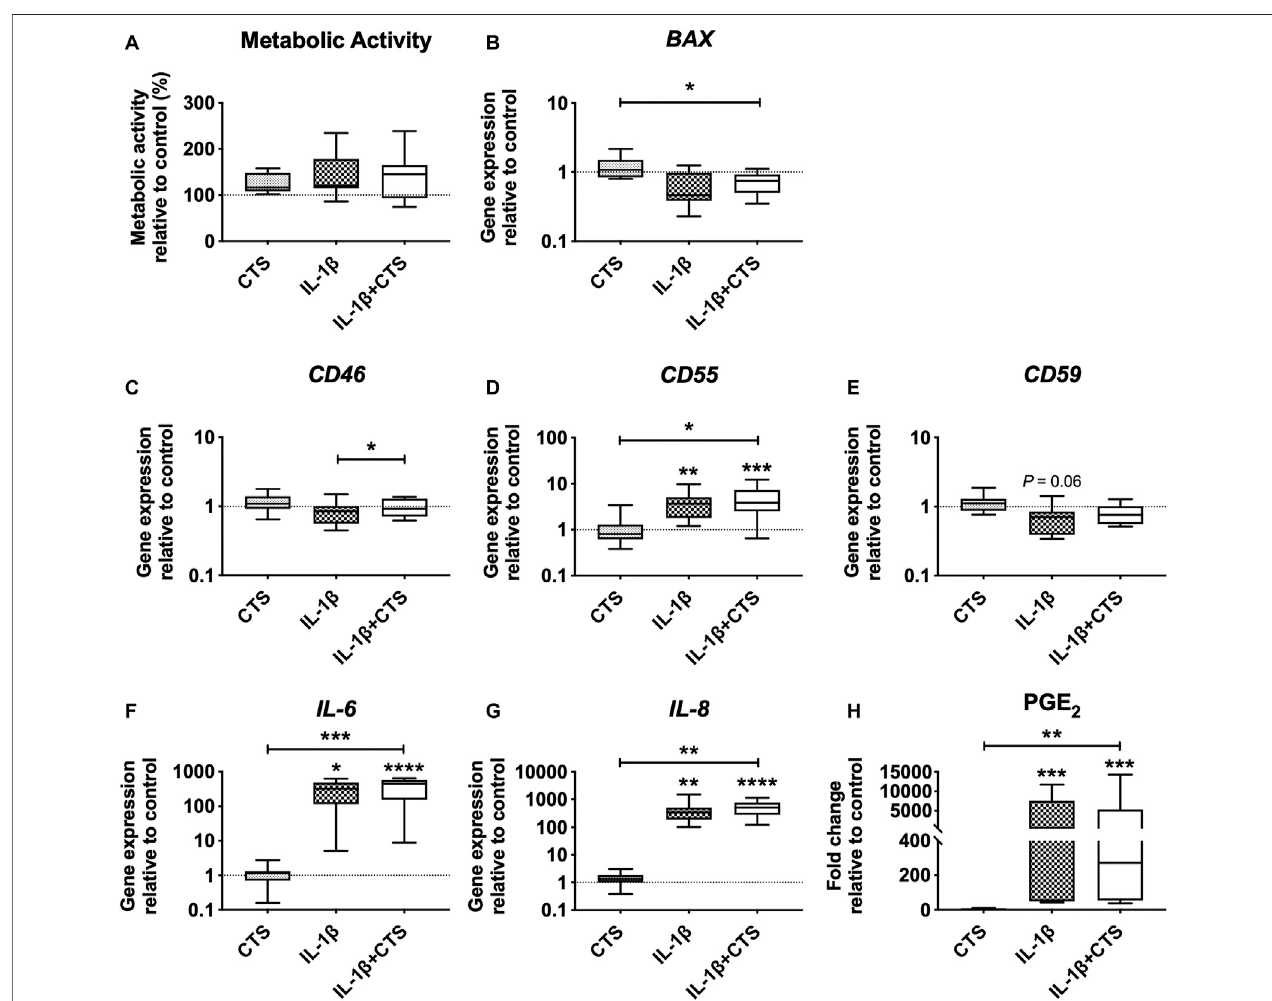
FIGURE 2 | Human annulus fi brosus (AF) cells metabolic activity and gene expression of cell apoptosis marker, complement factors, and pro-in fl ammatory cytokines,inresponsetocyclictensilestrain(CTS)andthepro-in fl ammatorycytokineIL-1 β (10 ng/ml)after48 h. (A) AFcellsmitochondrialmetabolicactivity(compared to unstimulated cells). Relative mRNA expression of (B) cell apoptosis marker BAX , (C) complement factors CD46 , (D) CD55 , and (E) CD59 ; pro-in fl ammatory markers (F) IL-6 and (G) IL-8 . Results were normalized to expression level of GAPDH and unstimulated cells. (H) Concentration of pro-in fl ammatory marker PGE 2 in (fold change to unstimulated cells). n (cid:1) 10, * p < 0.05, ** p <